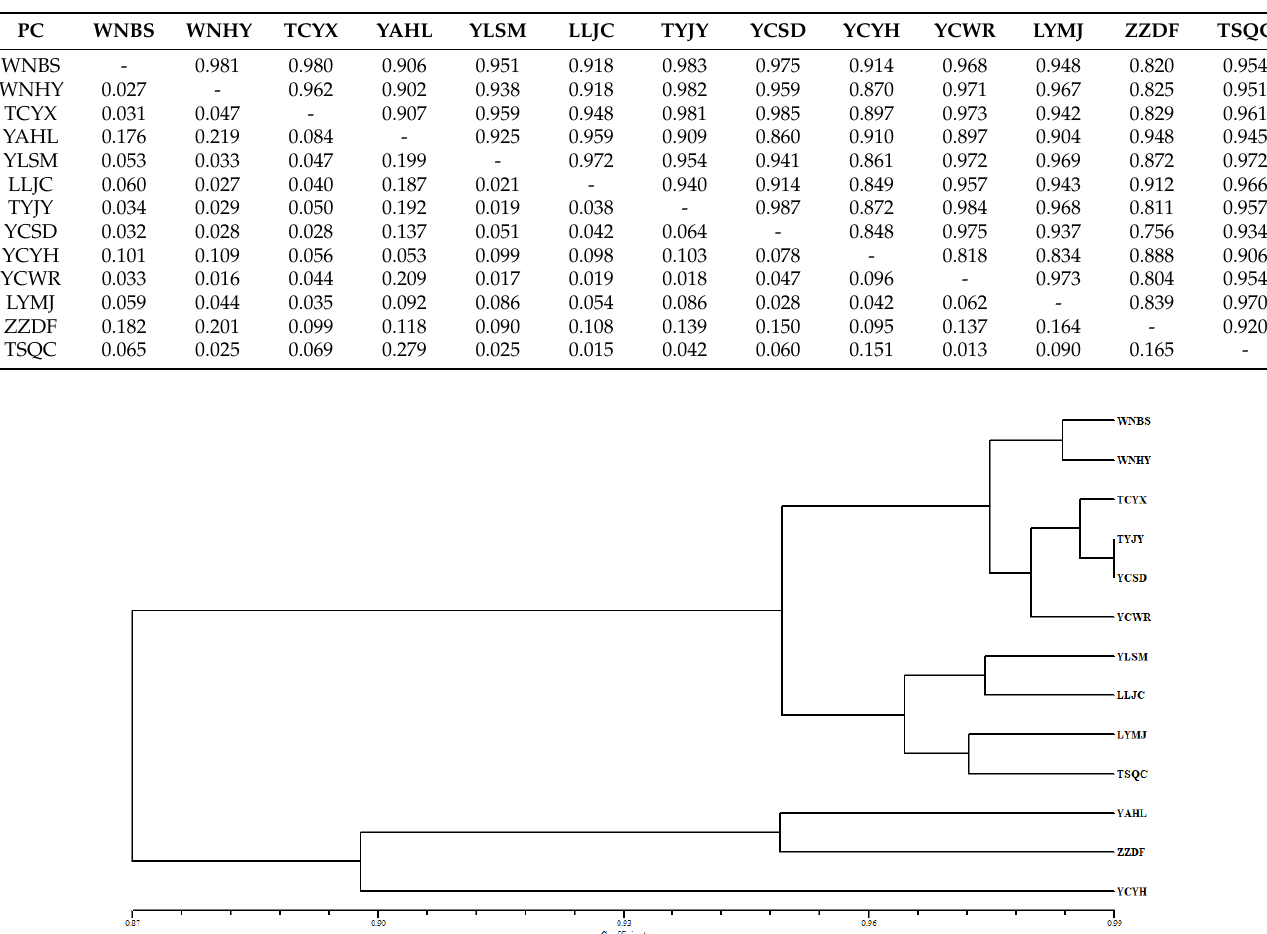
Table 5. Nei’s genetic identity (above diagonal) and genetic distance (D) (below diagonal) of 13 P. orientalis populations.